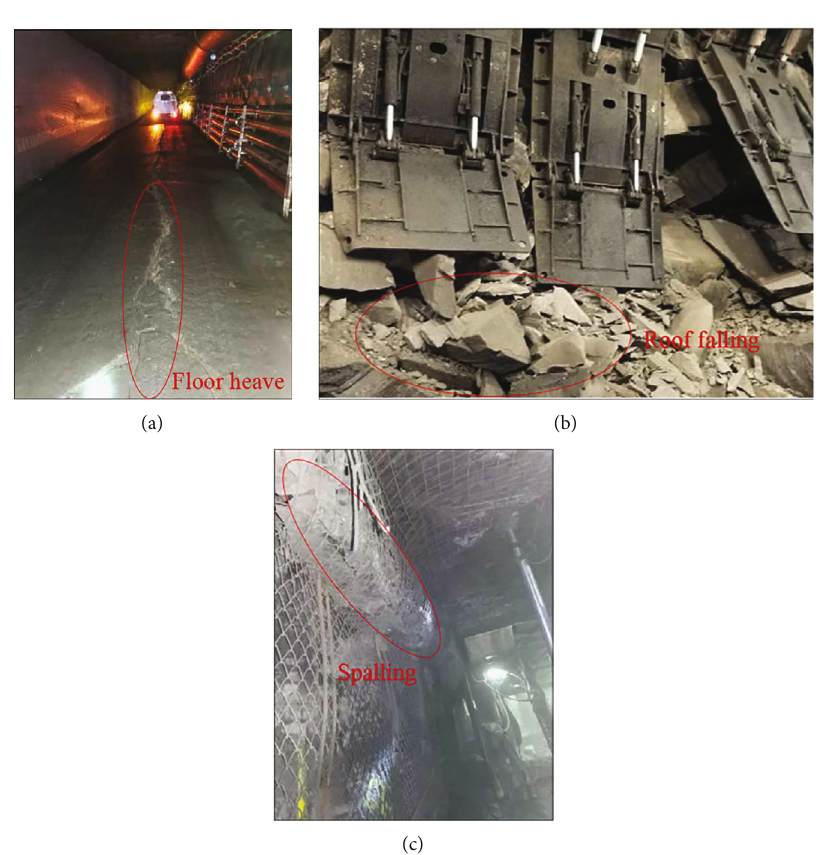
Figure 2: Roadway deformation and failure